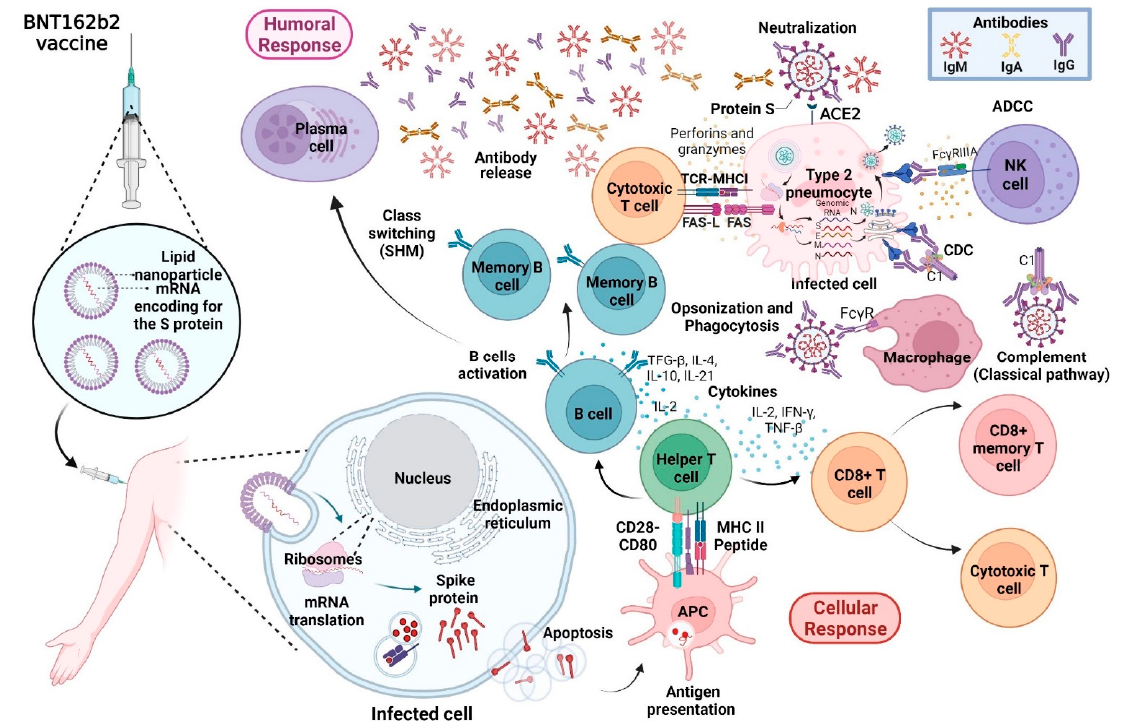
Figure 2. Immune response mechanism after the administration of BNT162b2 Pfizer/BioNTech vaccine. After its administration, the vaccine, which is composed of lipid nanoparticles with encapsulated mRNA, induced the production of the spike glycoprotein of SARS-CoV-2 in the host cells. After its recognition by the immune system, it generates a specific cellular and humoral immune response. Released antibodies promote ADCC, CDC, opsonization, neutralization, and complement activation (classical pathway). ACE2: angiotensin-converting enzyme 2; APC: antigen presenting cell;